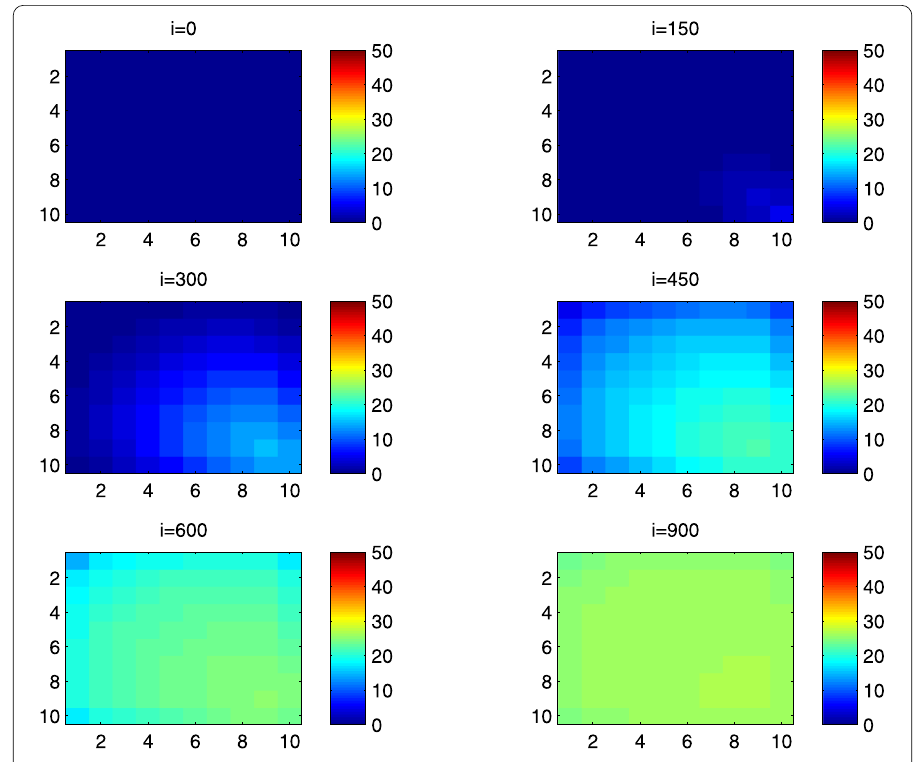
Figure 6 R Cpq behavior in the absence of control. The case when the disease starts from the corner C 11 .